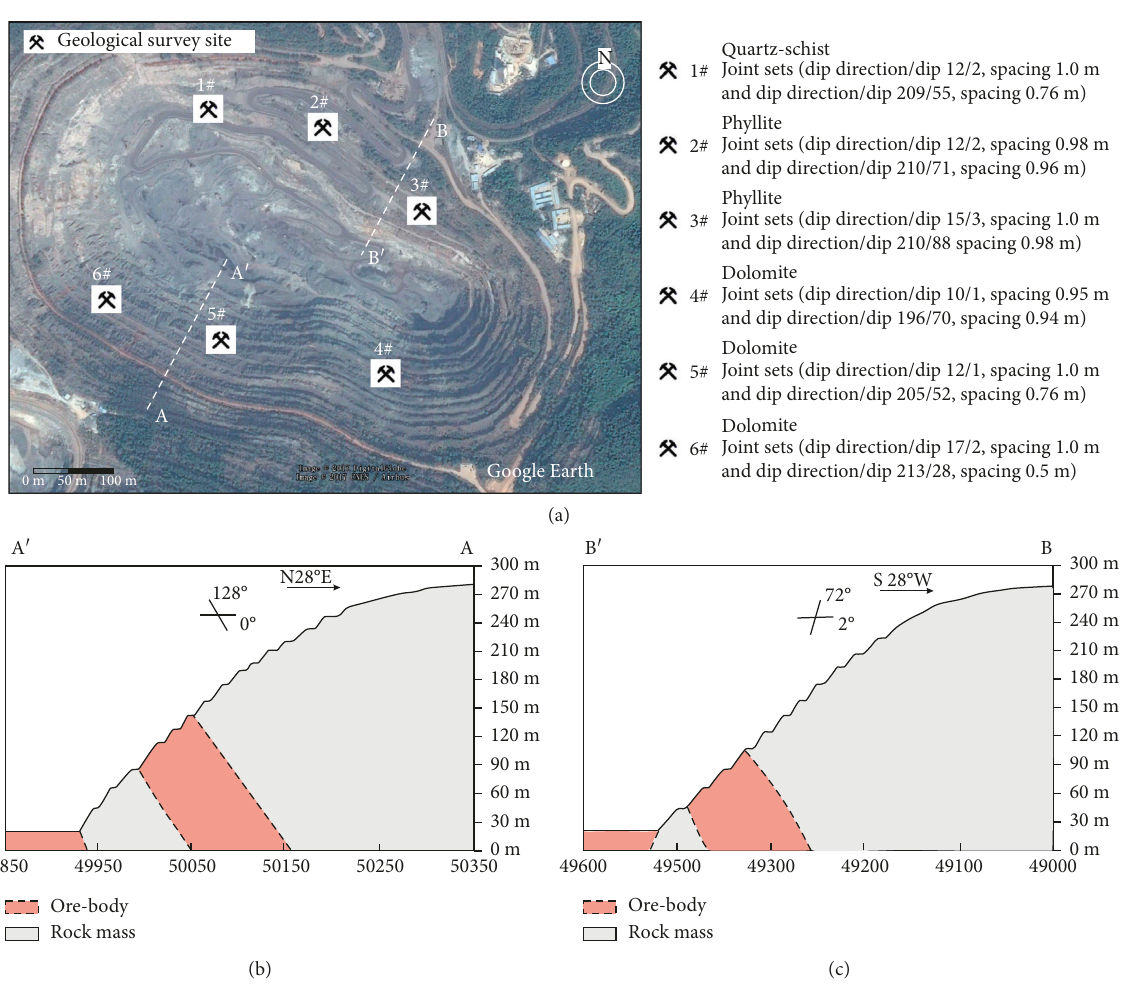
Figure 5: Distribution of geological survey sites and sectional views of the south and north slopes. (a) Geological survey sites. (b) South slope. (c) North